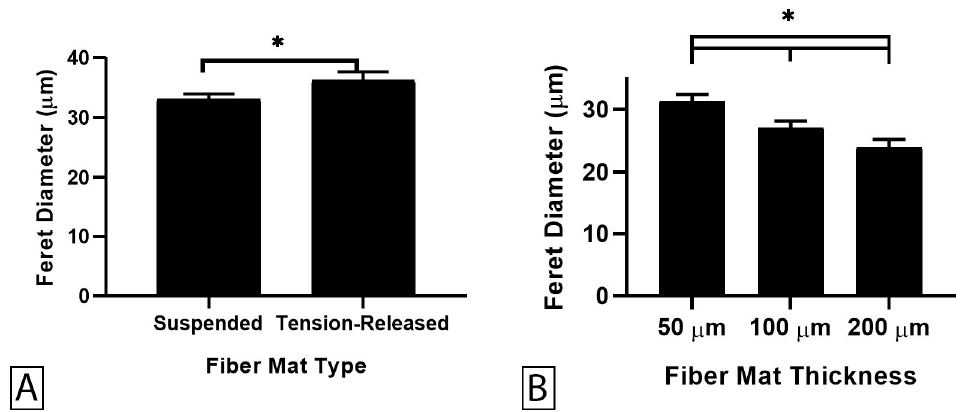
Figure 7. Average cell Feret diameter observed on tension-released and suspended EFM constructs, pooled data across all EFM thicknesses ( A ) and between tension-released mats at different fiber mat thicknesses ( B ). A total of 1651 cells were analyzed across at least two independent experiments. Levels connected by a star (*) are statistically significant from each other ( p < 0.05).